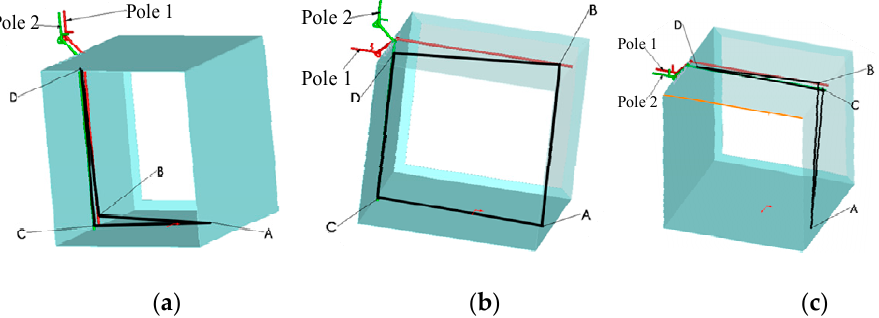
Figure 13. Samples in the trawl net and sample tube #3. ( a ) Initial state, ( b ) Working state, ( c ) Final state.